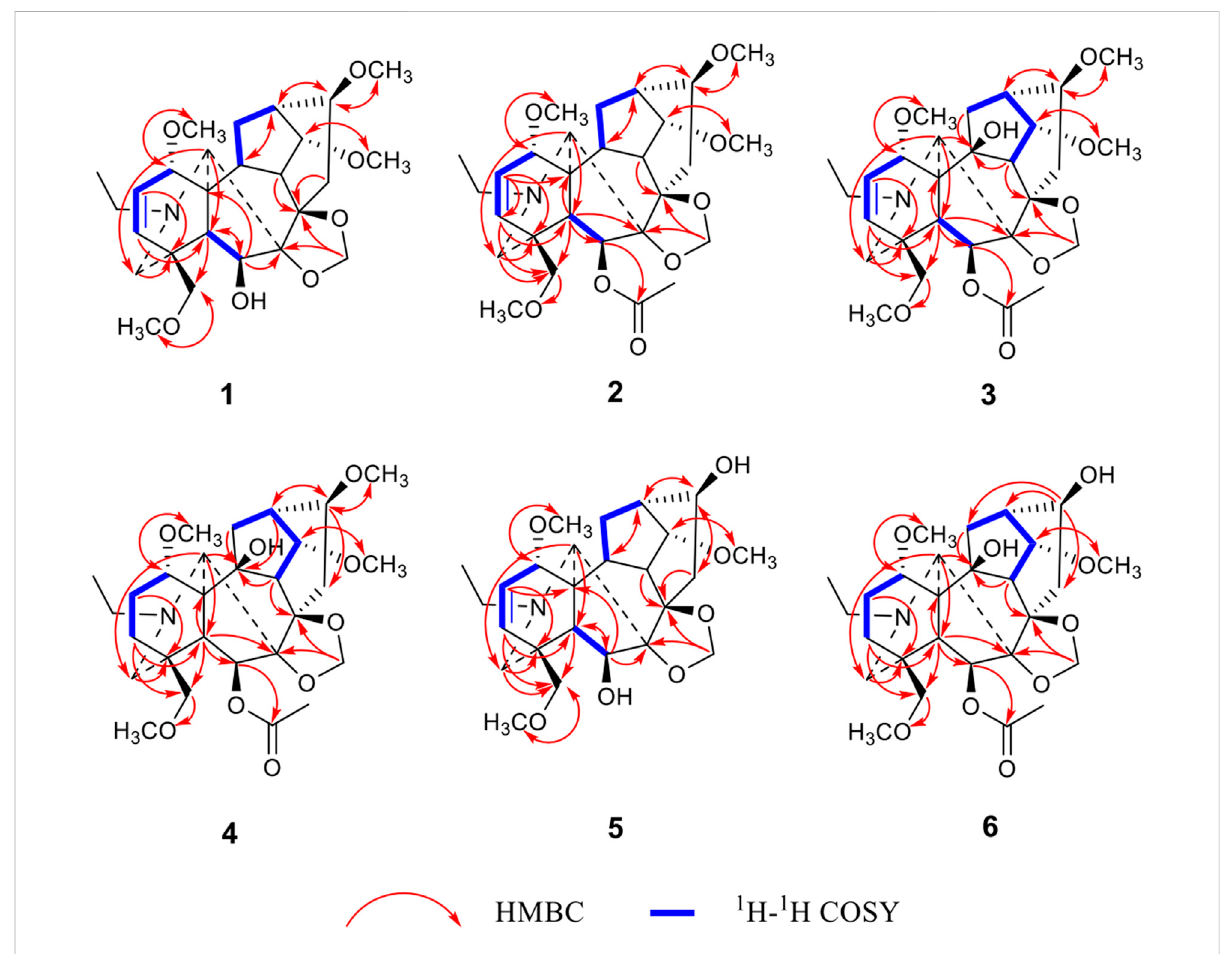
FIGURE 2 Key HMBC and 1 H – 1 H COSY correlations of six new diterpenoid alkaloids.